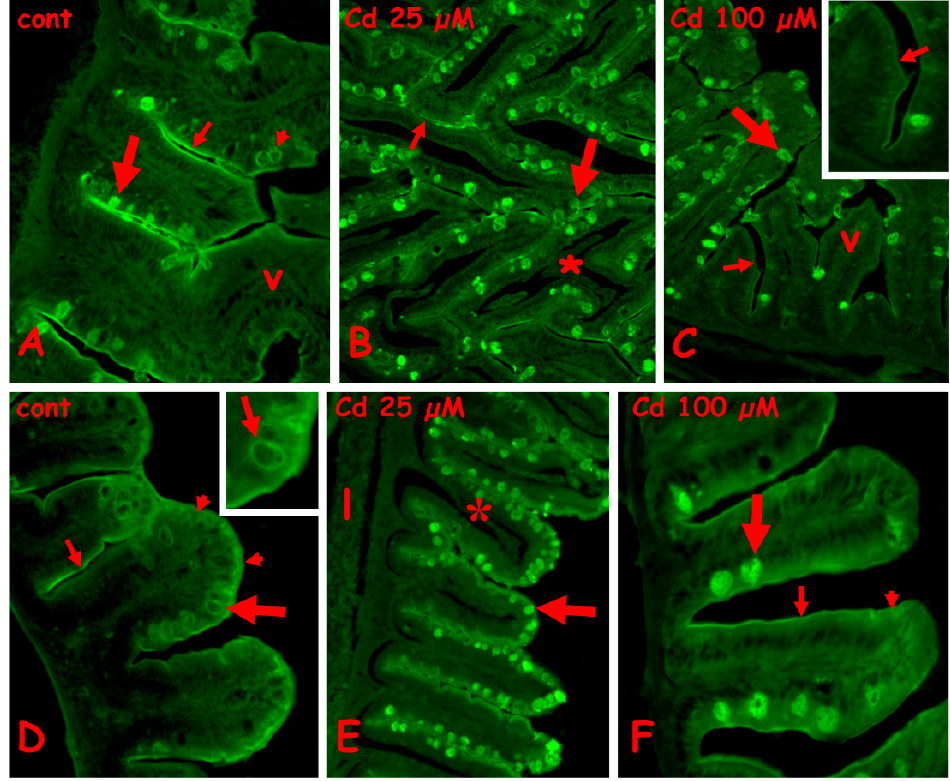
Figure 4. Effects of cadmium exposure on gut cells carbohydrate composition: staining for N-acetyl- glucosamine with fluorescent lectin WGA. Anterior ( A – C ) and mid ( D – F ) gut. ( A ) Villi (v) with labeled brush border (small arrow) and mucus vesicles in basolateral goblet cells (large arrow). In apical goblet cells labeling is cytoplasmic (arrowhead). ( B ) Intensely labeled apical goblet cells (large arrow) and brush border (small arrow). Seric infiltrate (*). ( C ) Labeled goblet cells in intact villi (v). Unstained brush border (small arrows). ( D ) Labeled brush border (small arrow), apical cytoplasm of enterocytes (arrowheads) and cytoplasm of goblet cells (large arrow and inset). ( E ) Labeled goblet cells (arrow) in villi with seric infiltrates (*). Unstained liver (l). ( F ) Labeled mucus vesicles in basal goblet cells (large arrow) and brush border (small arrow). Diffuse staining in the apical cytoplasm of enterocytes (arrowhead).